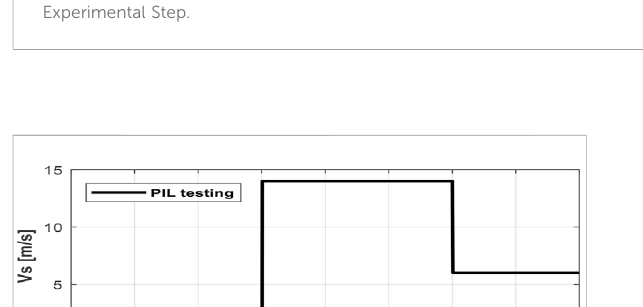
FIGURE 18 Experimental Step.